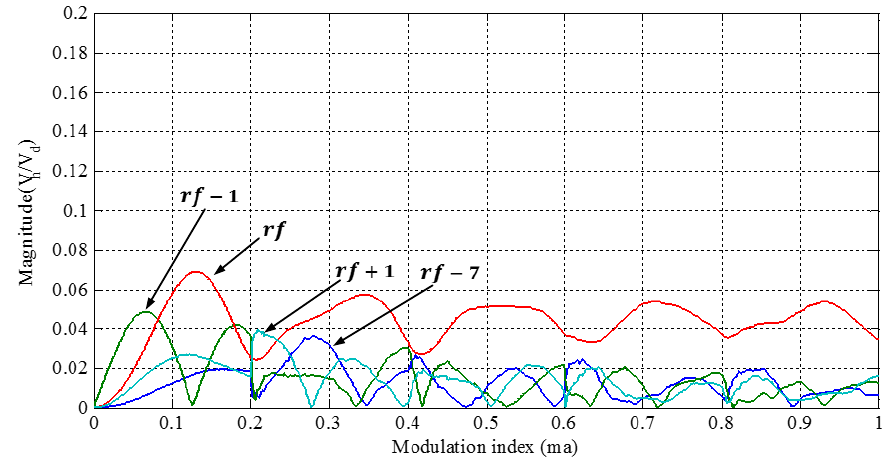
Figure 11. SVM harmonic distribution according to m a .